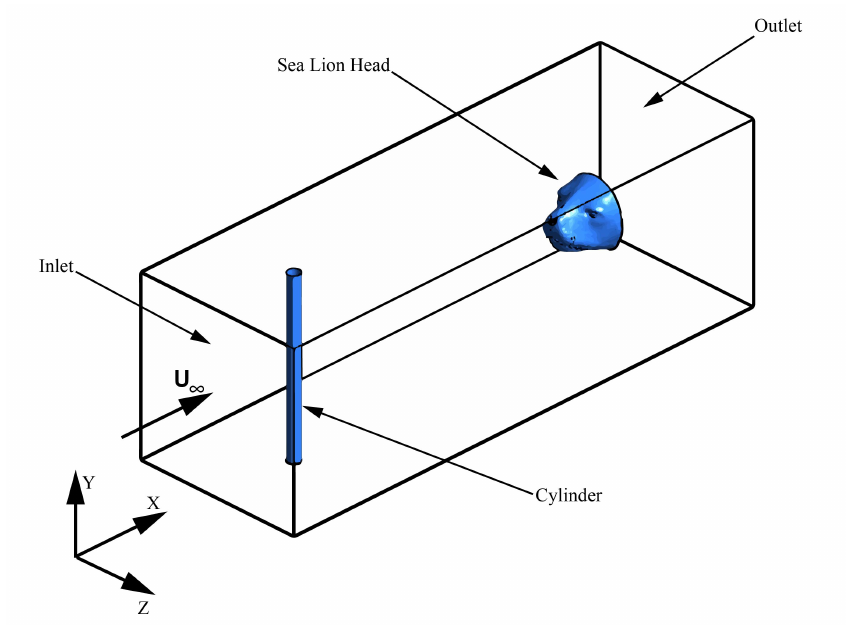
Figure 2. Sketch of the CFD domain and the flow configuration similar to the experiment. The domain extends 0.4 m in Y and Z directions and 1.2 m in X